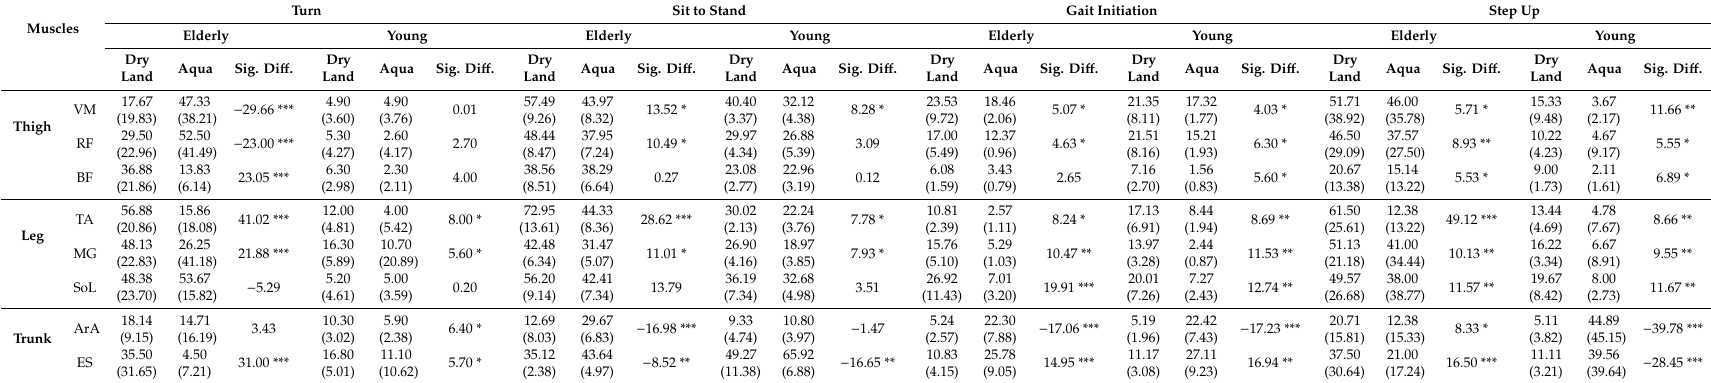
ArA: Anterior Rectus Abdominis; BF: Biceps Femoris; ES: Erector Spiane; GM: Gactocnemus medialis; RF: Rectus Femoris; SoL: Soleus; TA: Tibialis Anterior; VM: Vastus Medialis; *: p < 0.05; **: p < 0.005; ***: p <